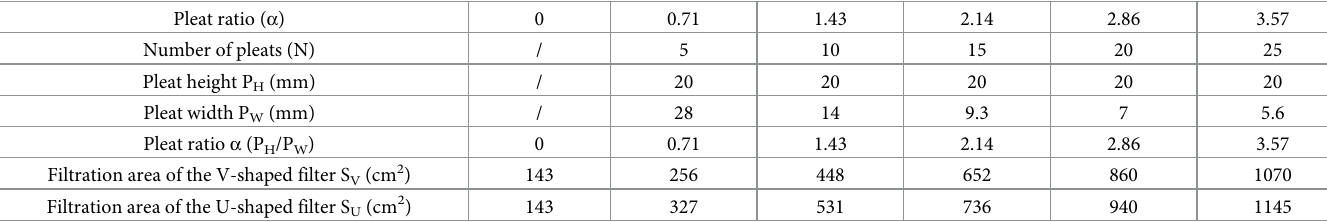
Table 1. Parameters of the self-made pleated